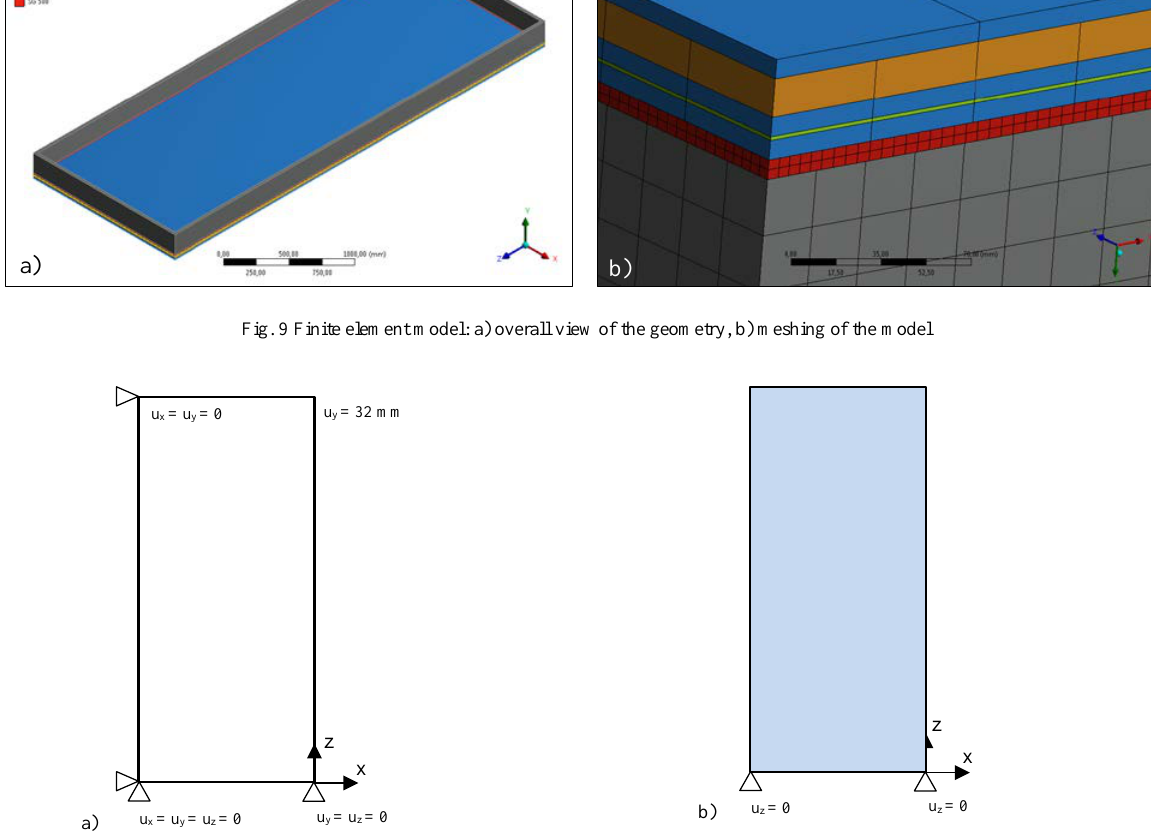
Fig. 10 Schematic representation of the supporting conditions of the finite element model: a) support of the aluminium substructure, b) additional support of the glass pane in case of temperature loading, which was taken into account in a second calculation step. The dead load of the glass is removed by setting blocks at the lower edge of the glass. This prevents the glass pane to expand in this direction in case of temperature changes. Correspondingly, the support conditions have to be different from those for forced installation. During the bending process the glass pane is able to move in all directions. In